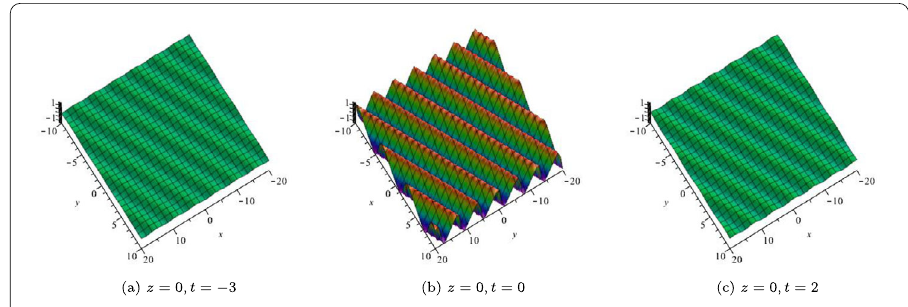
Figure 2 Line breathers of Eq. (1.2) in the ( x , y ) plane with parameters constrained by k 1 = k ∗ 2 = i , p 1 = p 2 = 1, q 1 = q ∗ 2 = i , η 10 = η 20 =